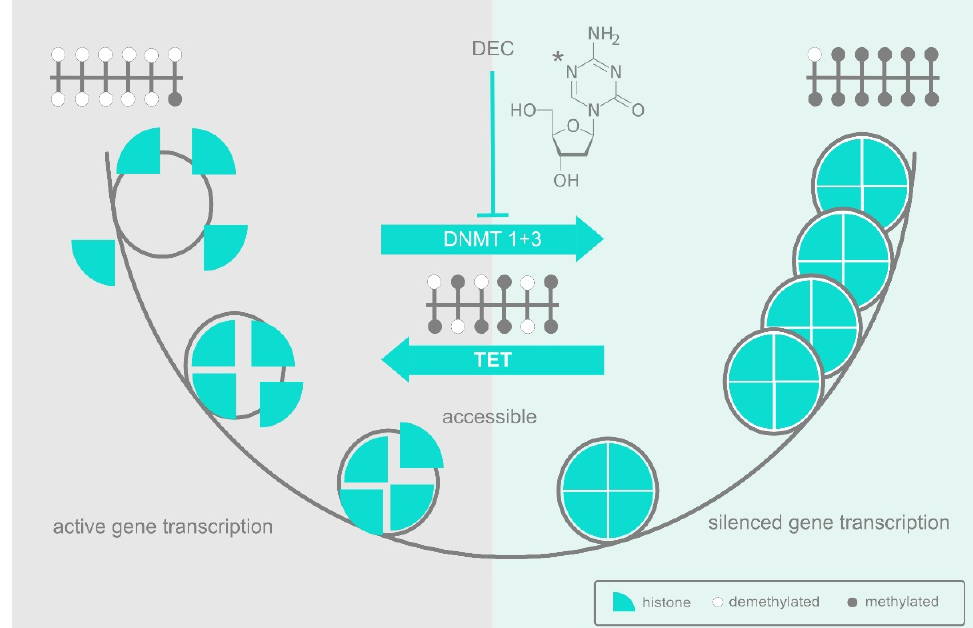
Figure 1. Azanucleosides affect DNA methylation and chromatin accessibility. A CpG island is shown at the top left of the figure in the predominantly non-methylated state (open circles) associated with active genes. Transcription factors can access their binding sites and modify histones to loosen histone/DNA interactions and open up the chromatin for transcription. In contrast, the CpG island at the top right is fully methylated (filled circles), preventing the binding of activating transcription factors. Tightly bound histones organise the DNA into nucleosomes and subsequently into higher order heterochromatin, locking in the inactive state. The CpG Island in the centre is in a dynamic, semi-methylated state subject to further methylation by DNMT enzymes or to demethylation by TET. Decitabine (DEC), shown top centre with the C5 position of the pyrimidine ring marked (*), depletes DNMT enzymes and tips the balance towards demethylation.